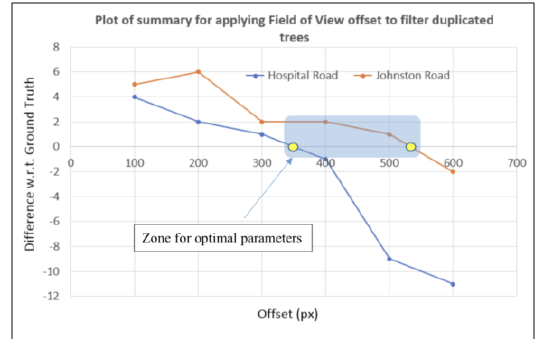
Figure 16. Plot of summary for Table